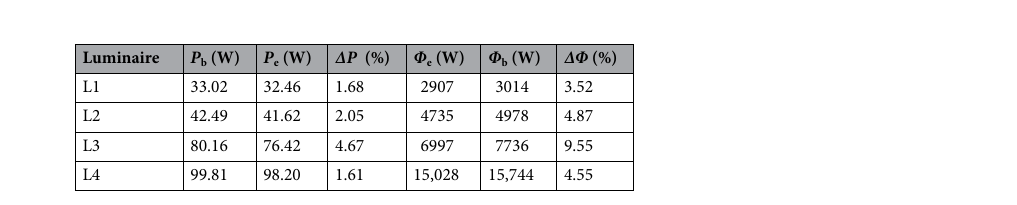
Table 2. Initial and final values of active power, luminous flux and their percentage differences of the tested luminaires.